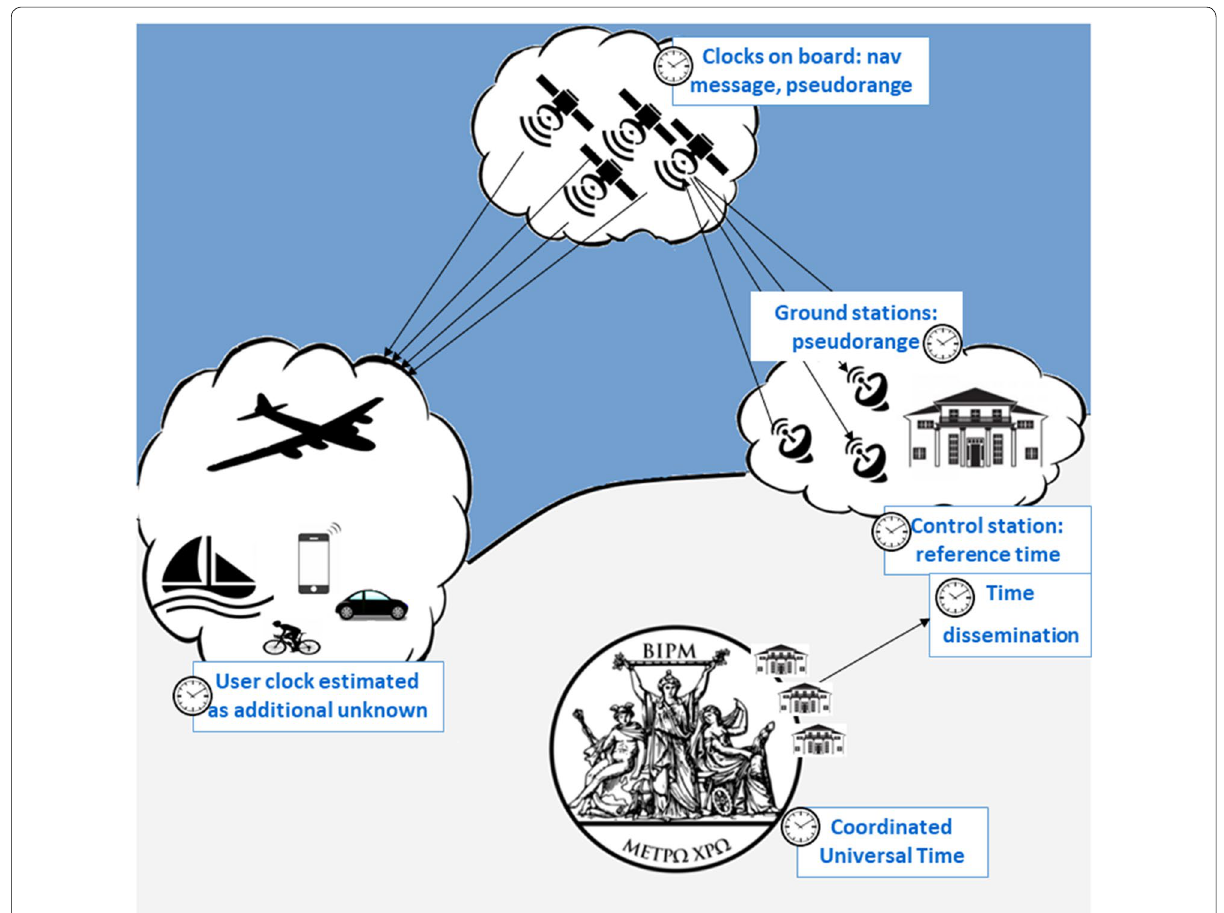
Fig. 1 The typical GNSS structure and the presence of